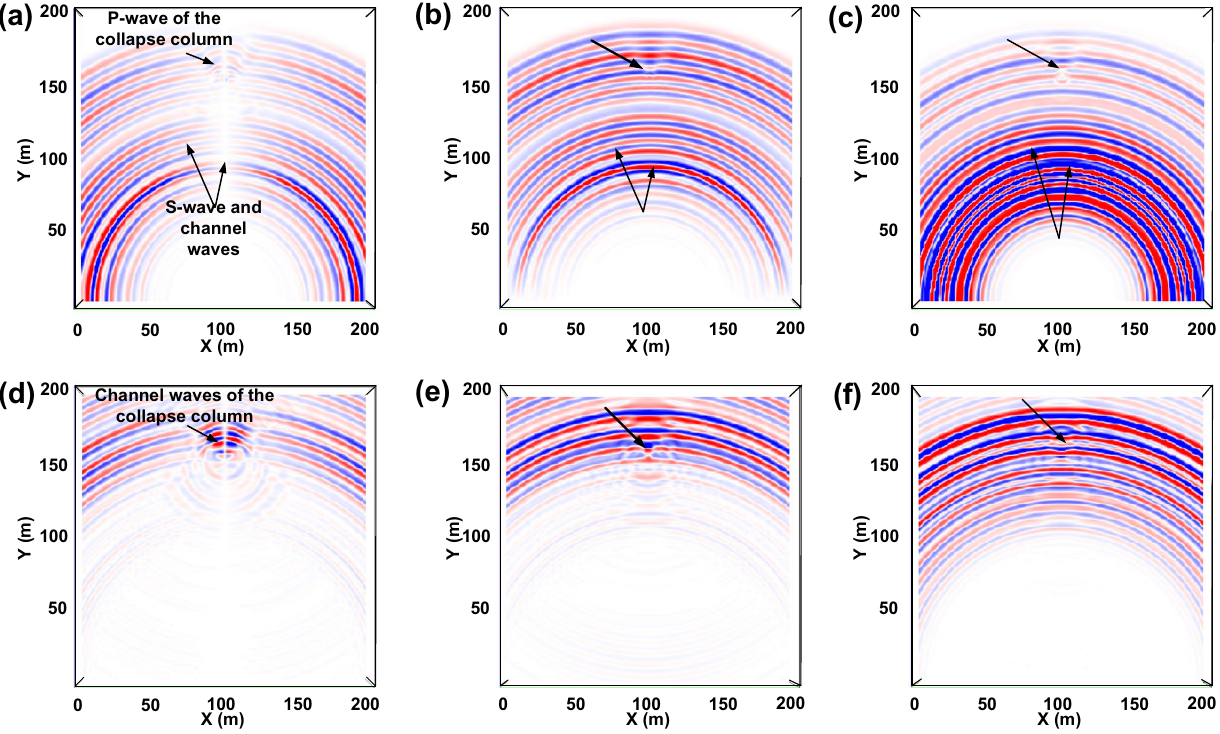
Fig. 6 XY-section snapshots of the simulated wavefield at different times ( Z = 50 m): a X component at T = 60 ms, b Y component at T = 60 ms, c Z component at T = 60 ms, d X component at T = 110 ms, e Y component at T = 110 ms, f Z component at T = 110